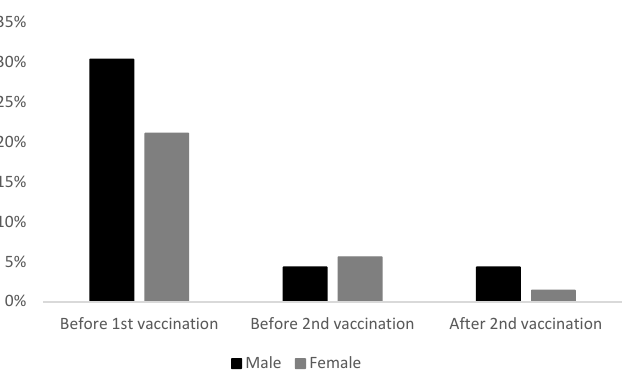
Figure 1. Difference in COVID-19 positivity (males and females) before first and second vaccination and after second vaccination. Table 2. Two-sided p -values for difference in COVID-19 positivity between body mass index (BMI) groups. * Significant if one-sided test was assumed.